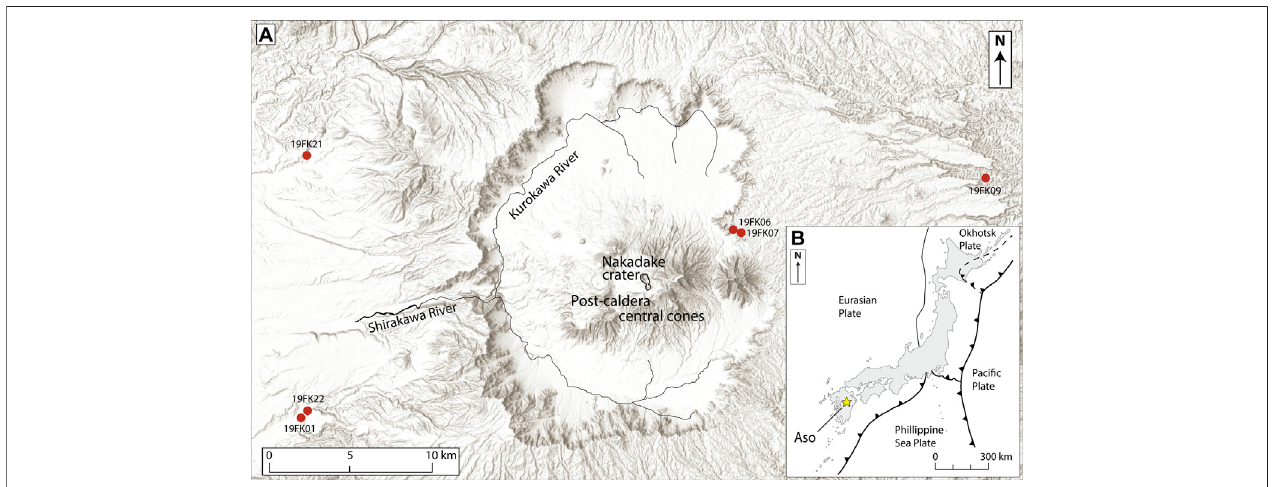
FIGURE 1 | (A) Location map of the sampling sites around Aso Caldera. The relief map was produced with the online ArcGIS viewer (https://www.arcgis.com/ home/webmap/viewer.html). (B) Location of Aso caldera (yellow star) in central Kyushu. Black lines indicate plate boundaries with triangles marking the sense of